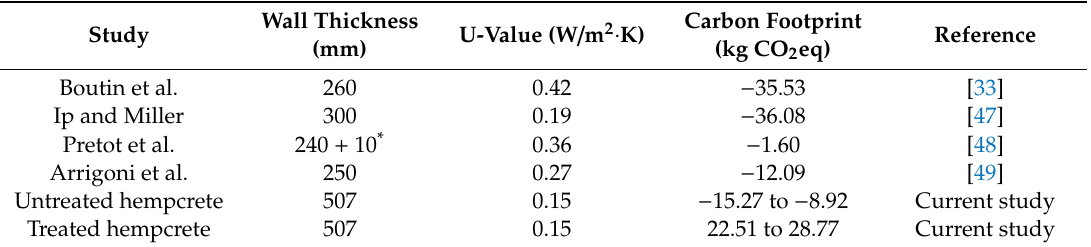
Table 5. Comparison of the carbon footprint of similar studies on hempcrete walls with the current